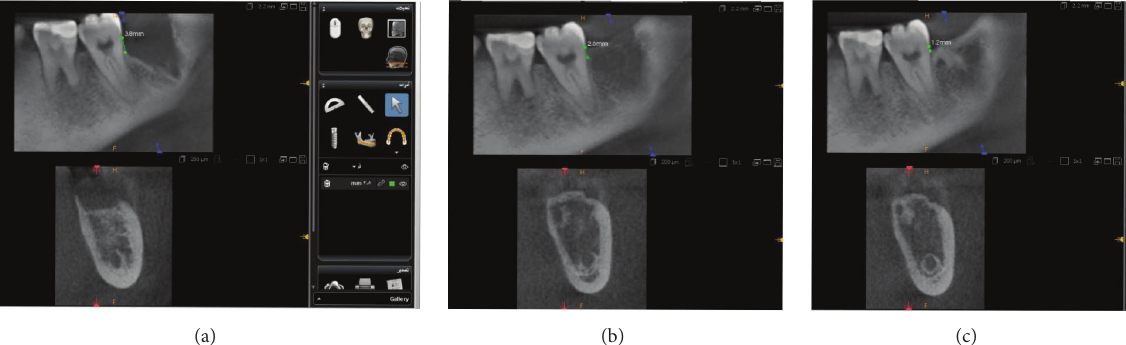
Figure 3: (a) Immediate, (b) 3-month, and (c) 6-month CBCT showing bone height measurement along the distal aspect of the second molar (test site).